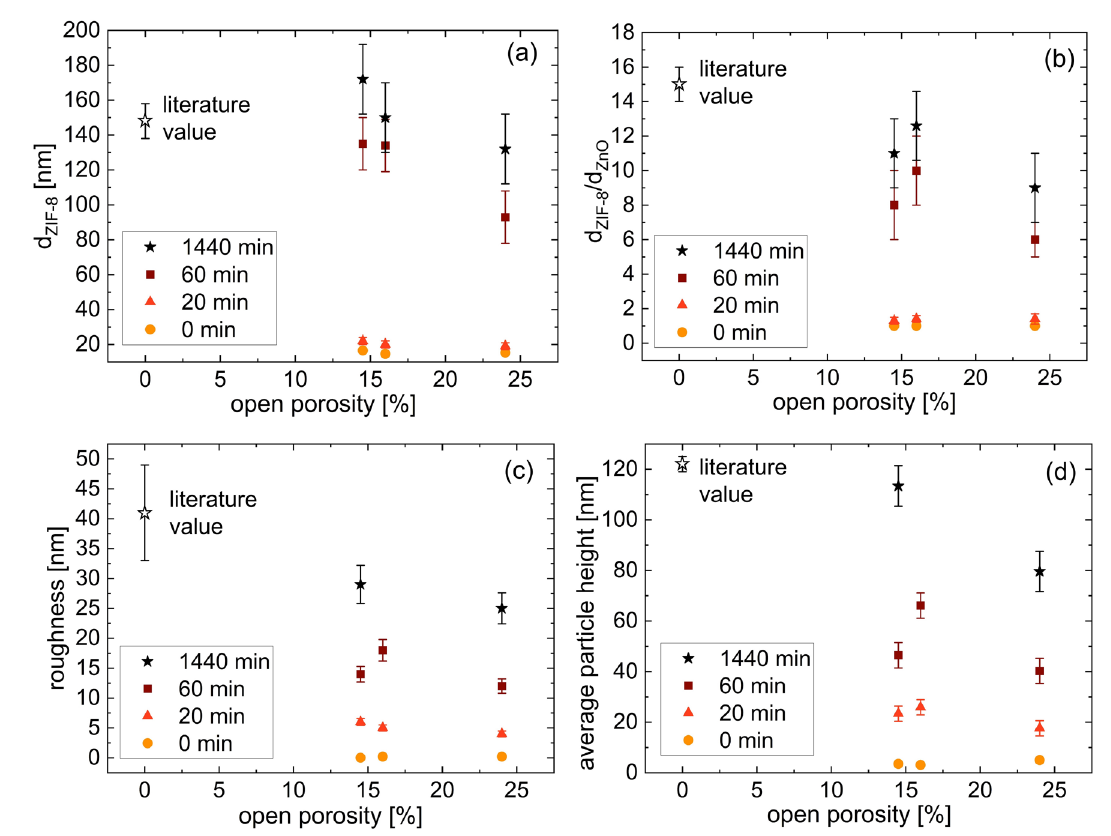
Figure 4. ( a ) Thickness as measured via spectroscopic ellipsometry, ( b ) thickness increase, ( c ) root mean square roughness, and ( d ) average particle height of ZIF-8 obtained after different conversion times from ZnO with open porosity values of 14.5%–24%. A literature value of ZIF-8 from non-porous ZnO is shown for comparison [16].